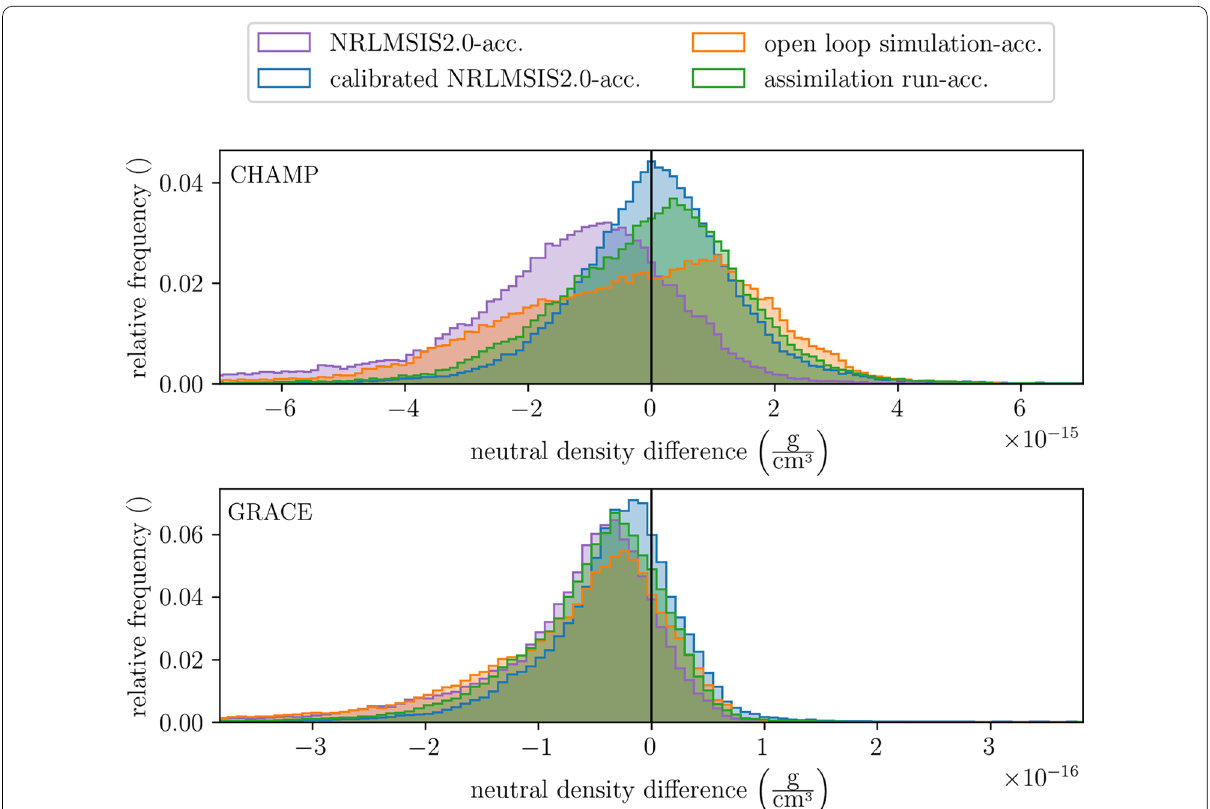
Fig. 12 The densities along the GRACE and CHAMP orbit were interpolated from the assimilated TIE-GCM and the open-loop simulation. Additionally, the (calibrated) NRLMSIS 2.0 was evaluated along the corresponding orbits. This figure shows the histograms of these three time series reduced by the accelerometer-derived densities. The histograms were calculated over the 14-day period of the